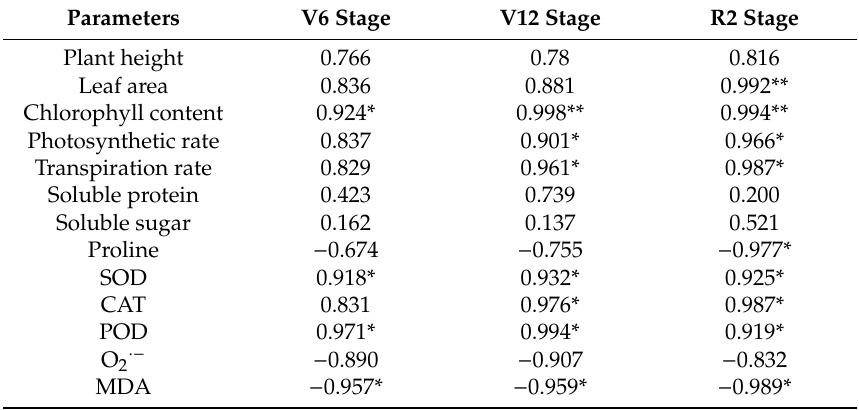
Table 4. Pearson correlation analysis between maize yield and selected growth and physiological parameters measured at di ff erent growth